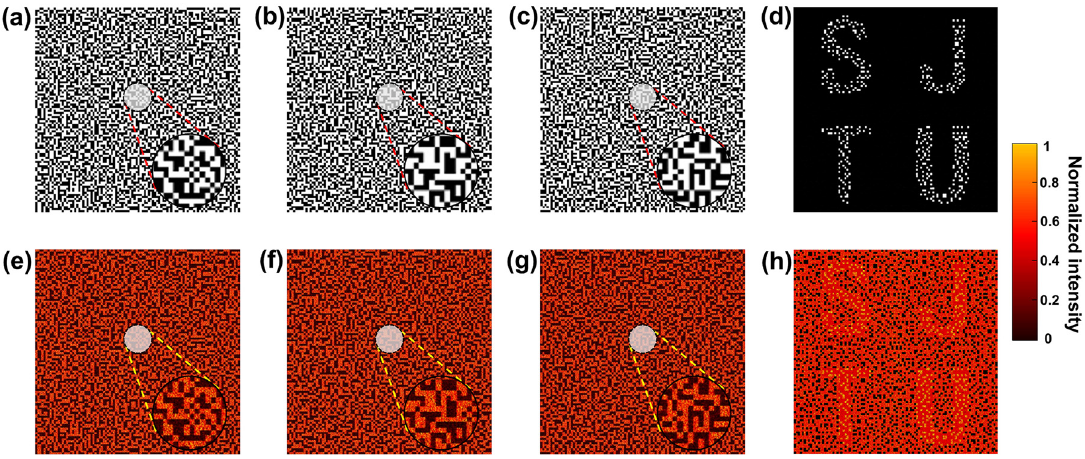
Figure3: OriginalreferenceresultsandsimulationresultsoftheSSPEschemewithmultiplemetasurfaces.(a – c)OriginalSKsand(d)stacking result. (e – g) Reconstructed images of SKs and (h) corresponding revealed